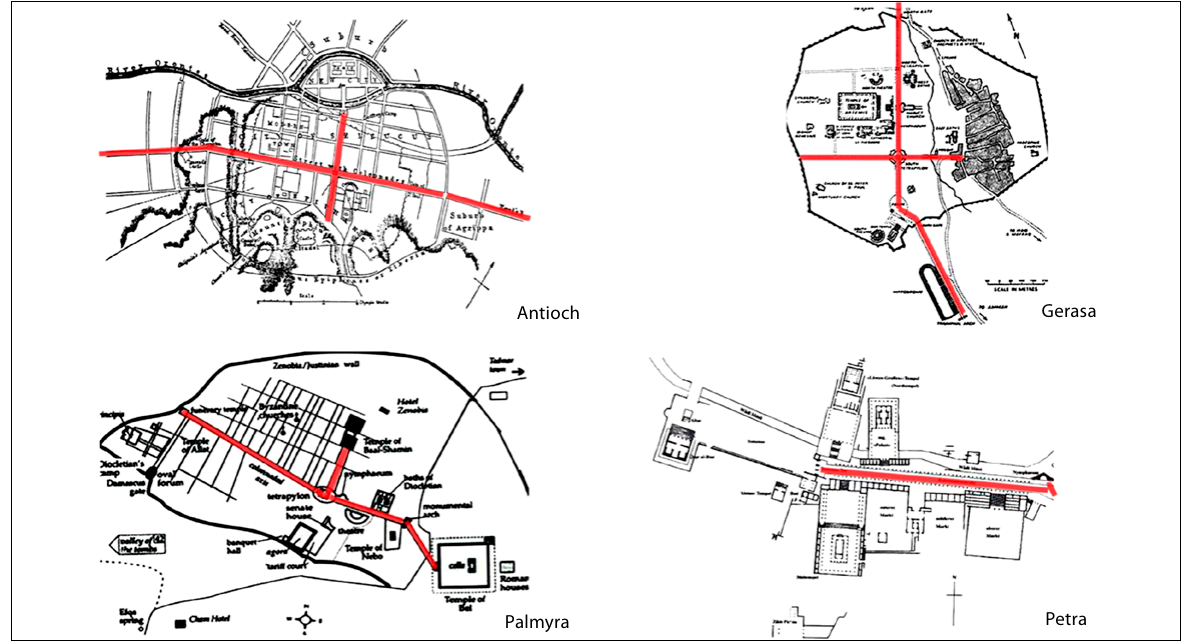
fig. 1. The colonnaded streets as appeared in the roman East cities of Antioch, Palmyra, Gerasa, and Petra. Sources : modified from http://www.bible-history.com/ibh/Geography,+Plans,+Maps/Syria/, http://www.computer-render.com/Pages/Gerasa_2.html,